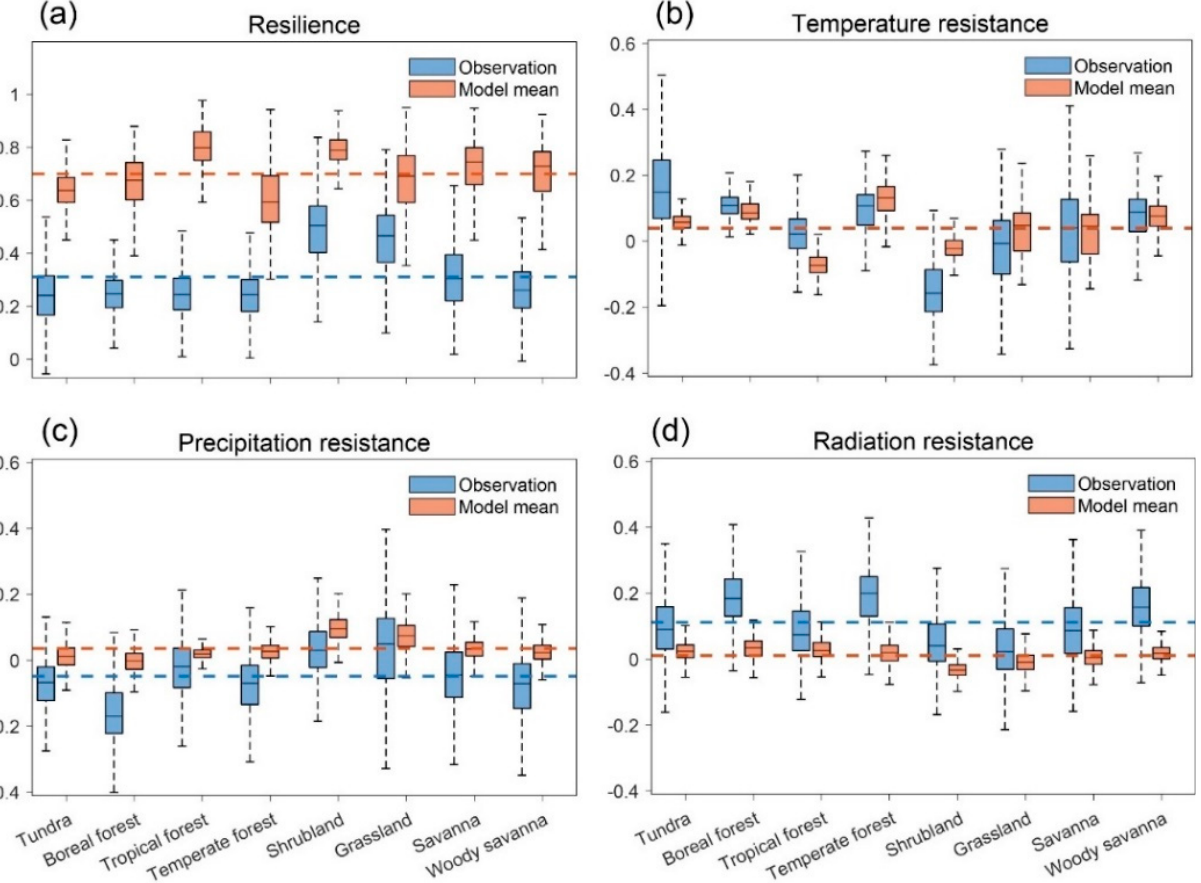
Figure 5. Box plot of observation and model mean vegetation resilience and resistance at the biome scale: ( a ) vegetation resilience; ( b ) temperature resistance; ( c ) precipitation resistance; ( d ) radiation resistance. The horizontal dashed lines represent the mean vegetation resilience and resistance of the eight biomes.